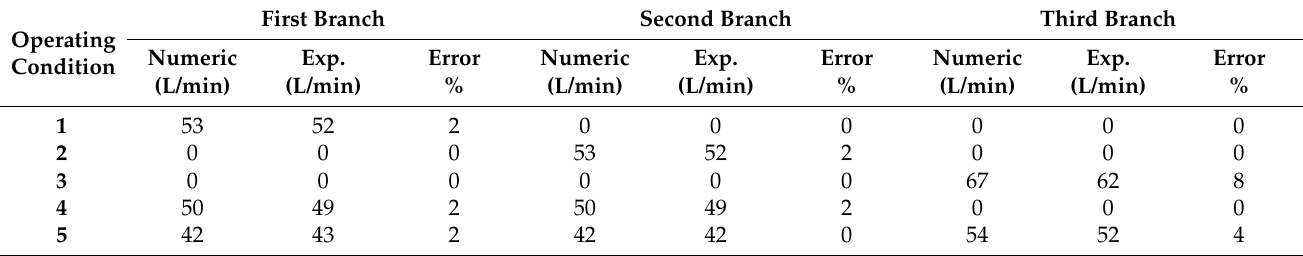
Table 1. Comparison between the numerical and the experimental